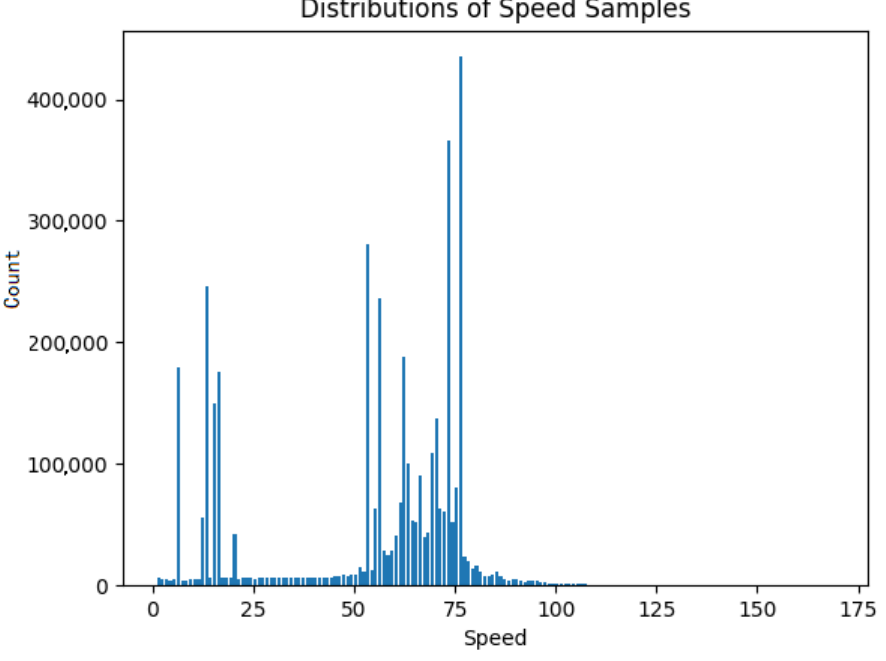
Figure 2. Speed samples distribution.